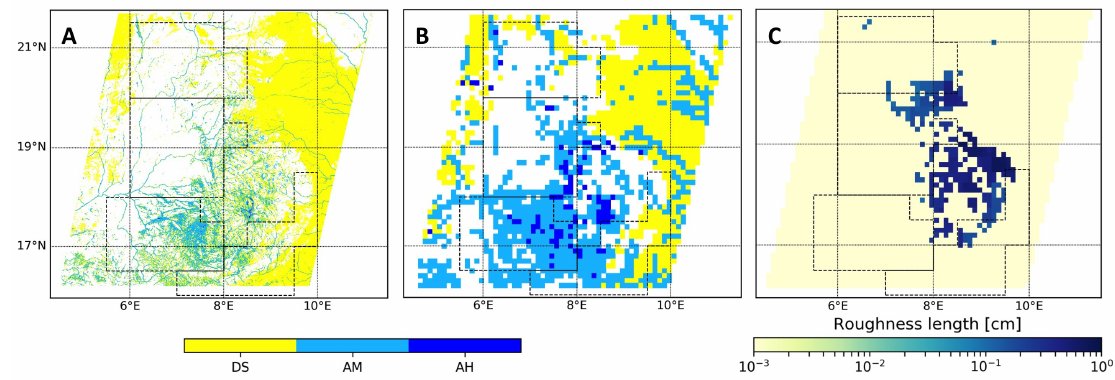
Figure 4. Sediment Supply Map (SSM) including dunes and sand sheets (DS), medium emitting alluvial (AM), and high emitting alluvial sediments (AH) for: ( A ) the original resolution; and ( B ) after the resampling to model grid spacing; and ( C ) the aerodynamic roughness length of the overall surface (Z 0 ) adapted as described in Section 5 in model grid